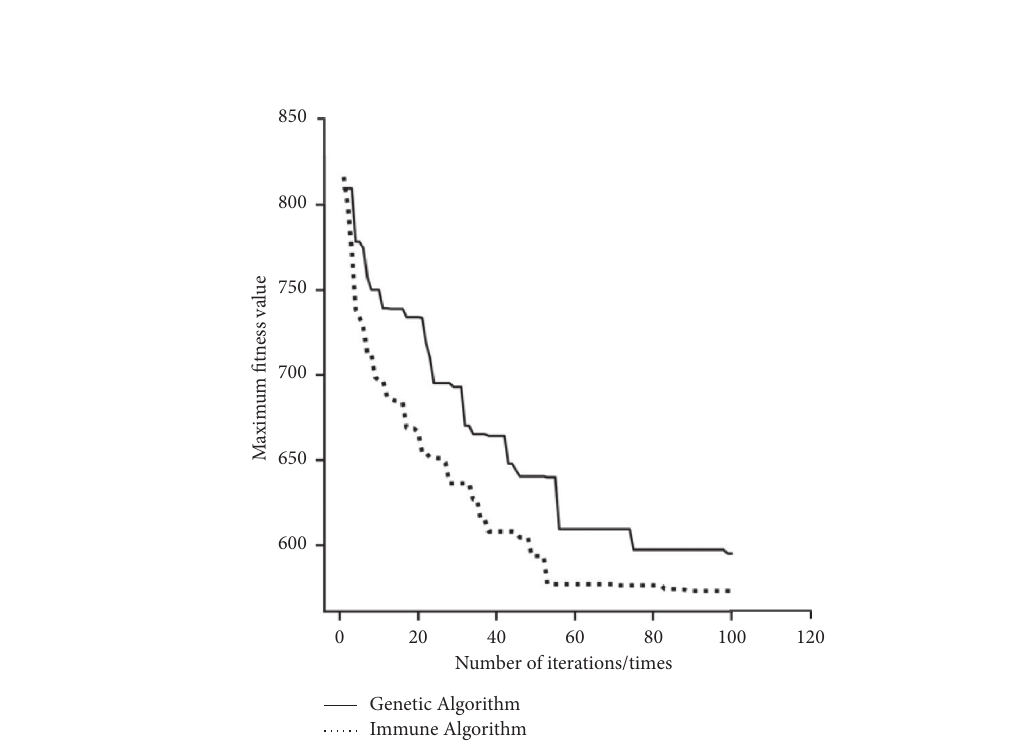
Figure 2: Fitness curve of immune and genetic